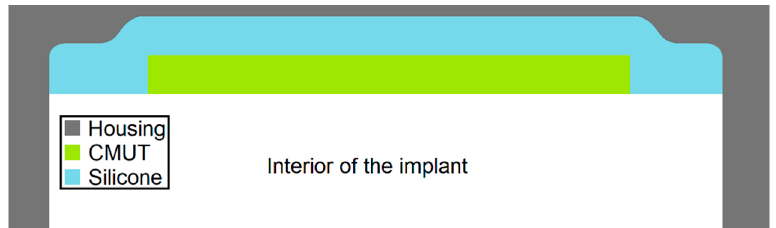
Figure 4. Schematic sketch of the CMUT chip inside the housing of the medical implant.